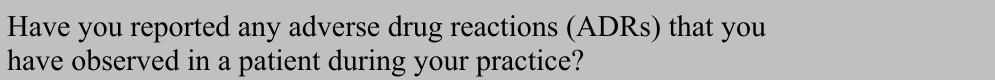
Table 3: Practices regarding pharmacovigilance (N=107)